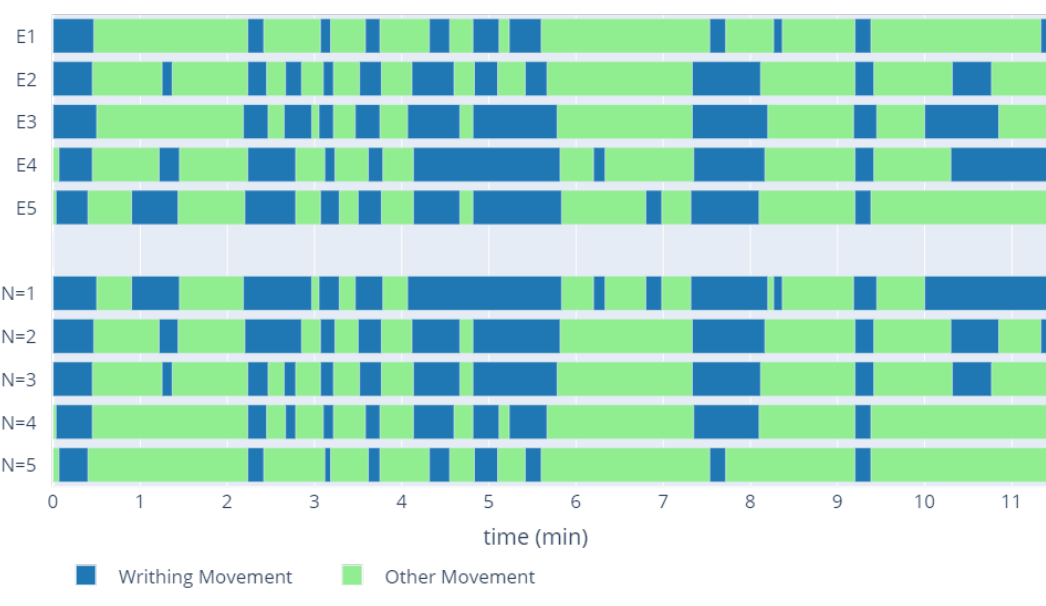
Figure 2. Examples of indications of WM fragments by different experts (E1–E5) for one recording. The intervals denoted N = 1–5 present the ground truth depending on the number of experts for whom the common part was